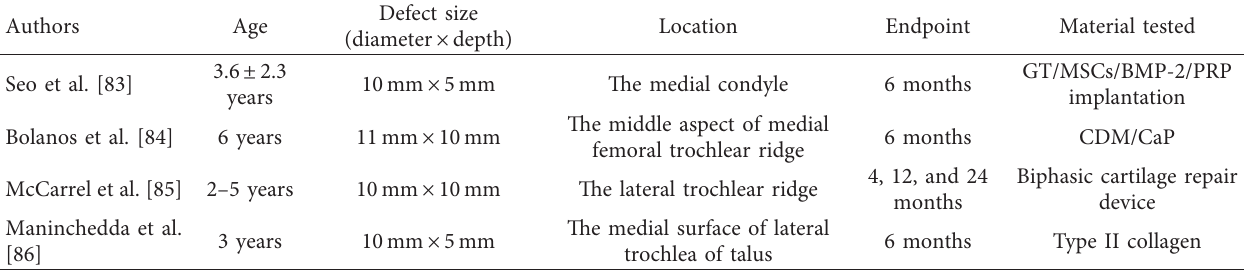
Table 8: Examples of studies using horse osteochondral defect models.